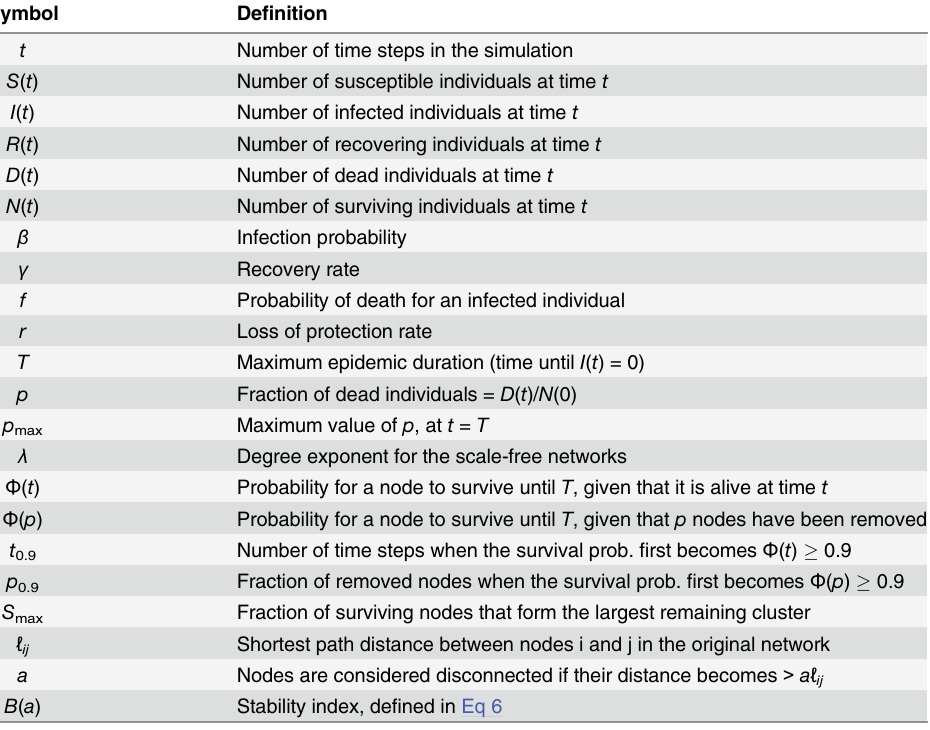
Table 1. Definitions of the main parameters and properties used in the paper.